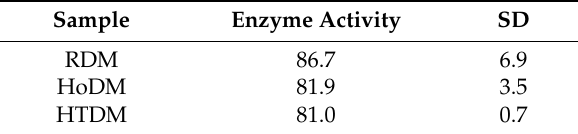
Table 3. Lysozyme activity in donkey milk before (RDM—raw donkey milk) and after HTST (HTDM— HTST donkey milk) and Holder (HoDM—holder donkey milk) pasteurization. Means are expressed